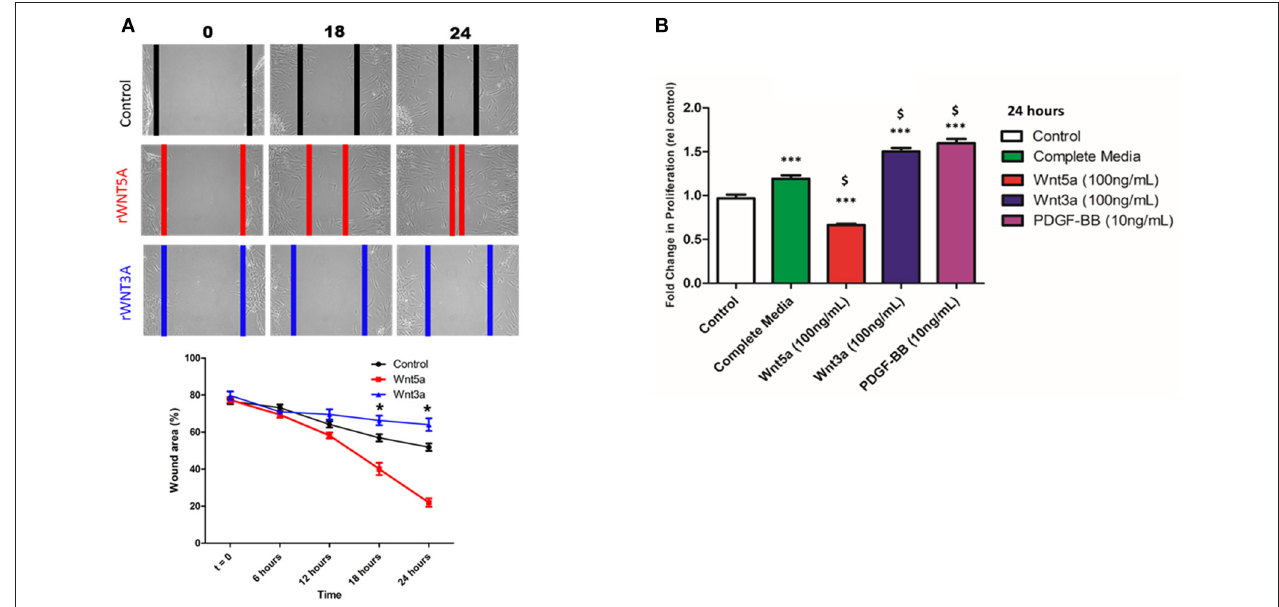
FIGURE 6 | WNT Proteins Differentially Regulate VSMC Migration and Proliferation. (A) Representative phase-contrast microscopy images of migrating VSMCs in response to rWNT5A or rWNT3A. Cells were grown to confluence and subjected to wound-healing scratch assay. After the scratch, VSMC were washed 2x with PBS and incubated in rWNT5A or rWNT3A supplemented medium (both 100ng/mL). VSMCs were then imaged every 6h. Colored vertical lines are the estimated wound borders for clarity. Quantification was performed on phase-contrast images. rWNT5A promoted migration in comparison to untreated control (UT), as evidenced by a significant decrease in % wound area (* p < 0.01, n = 5 experiments). Additionally, rWNT3A inhibited migration compared to UT (* p < 0.01, n = 5 experiments). (B) Results of MTS proliferation assays in VSMCs. Cells were seeded at ∼ 60% confluence then incubated for 24h in basal medium to induce quiescence. After 24h, cells were then incubated with the indicated treatment medium. Date were normalized to a standard curve to determine cell number and represented as fold change. rWNT5A inhibited cell proliferation relative to control and complete medium, whereas rWNT3A induced VSMC proliferation almost to the same degree as the positive control (PDGF-BB). Data are representative of five independent experiments with each group performed in triplicate, $ p < 0.05 relative to complete medium; *** p < 0.001; ns = not significant relative to control for each time